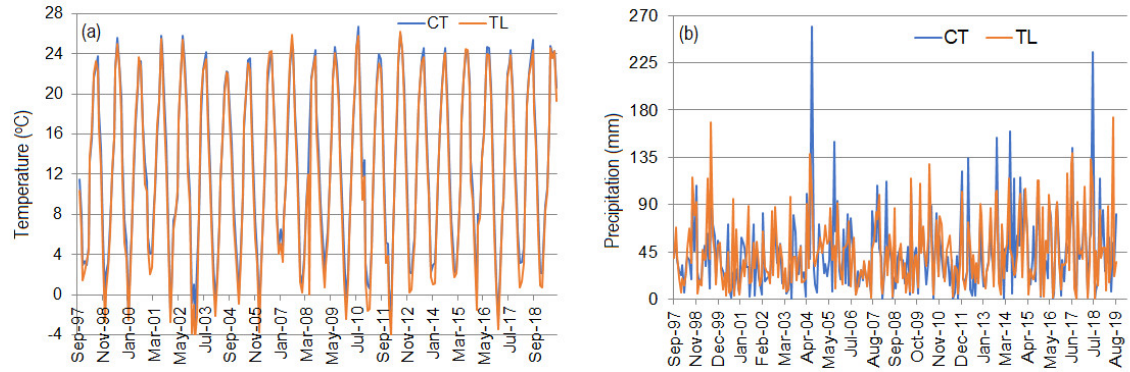
Figure 3. Monthly average ( a ) temperature and ( b ) precipitation series recorded at Constanța (CT) and Tulcea (TL). Table 1. Basic statistics of the CT and TL monthly series used for